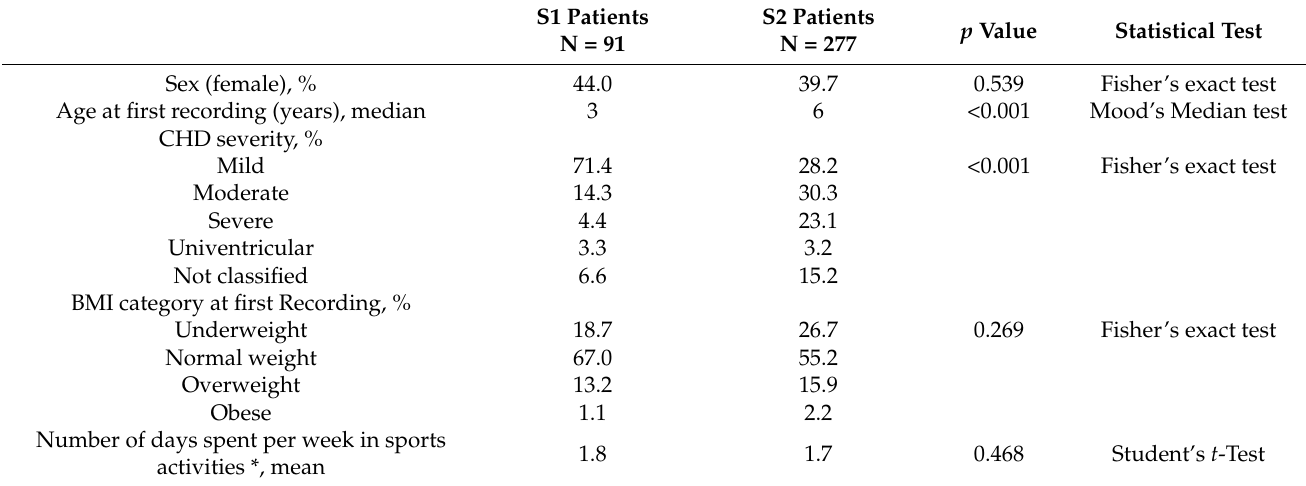
Table 3. Comparison between patients with only one clinical visit (S1) and patients with at least two clinical visits